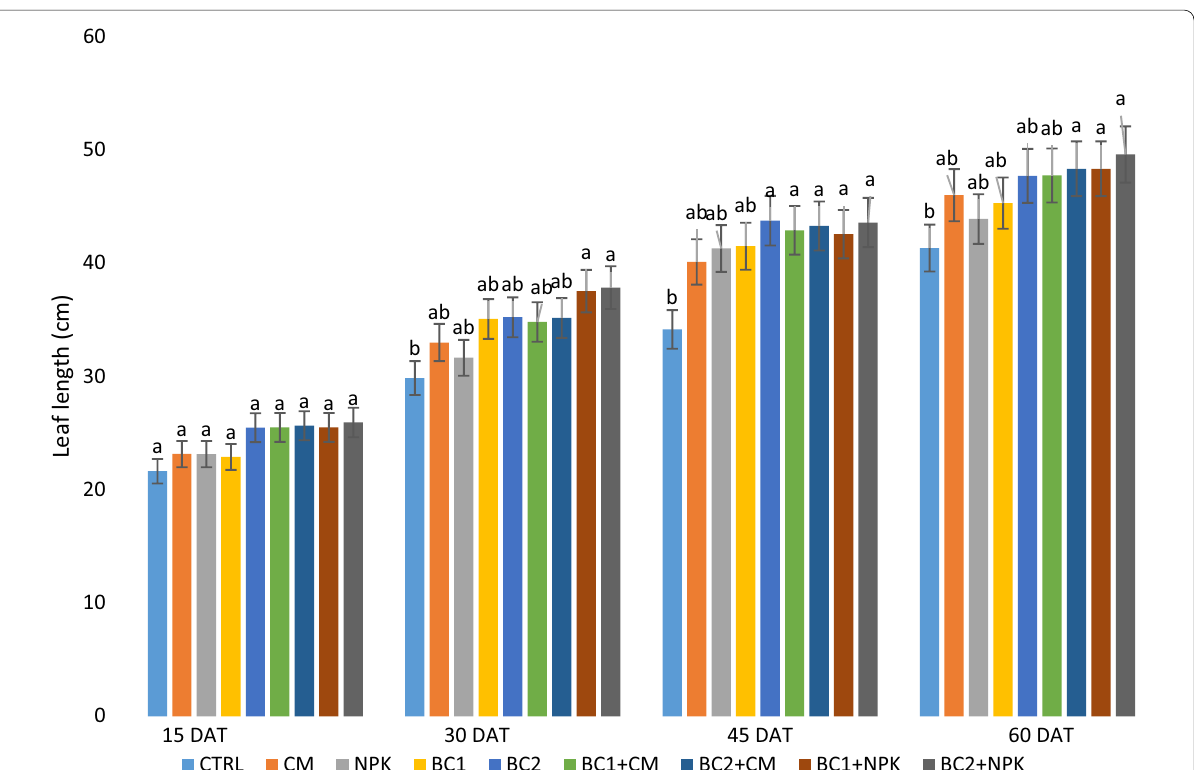
Fig. 2 Residual Effect of biochar, farmyard manure compost and/or NPK on the collard plant leaf length. The same letter on the bars are not significantly different at p 0.0 5 using Tukey HSD; Control (CTRL), 10 t/ha compost only (CM), 200 kg NPK (NPK), 10t/ha Biochar only (BC1), 20 t/ ≤ ha Biochar only (BC2), 5 t/ha Biochar 5 t/ha compost (BC1 CM), 10 t/ha Biochar 5 t/ha compost (BC2 CM), 5t/ha Biochar 100 kg/ha NPK + + + + + (BC1